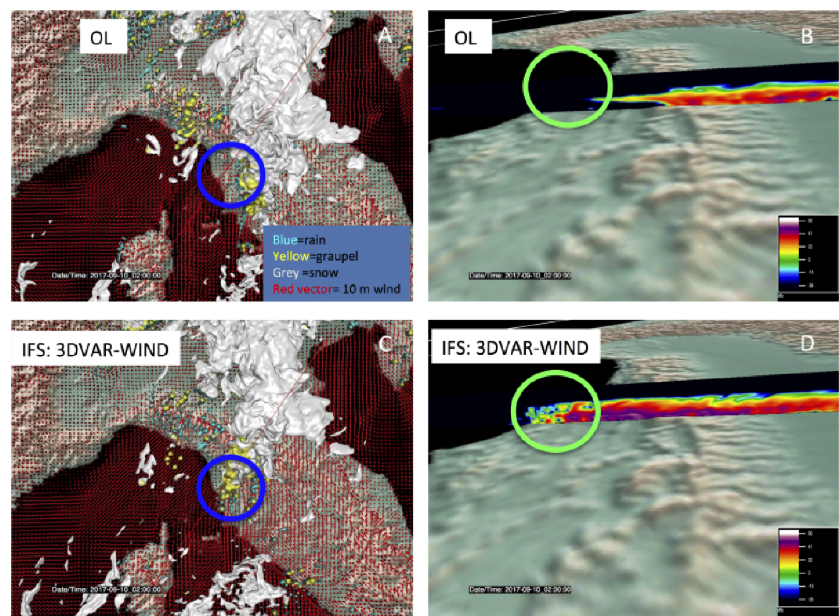
Figure 11. Comparison between the OL simulated structure with respect to the 3DVAR-WIND simulated structure at 02 UTC of 10 September 2017. Panels ( a , c ) report the 3D simulated structure composed by rainwater (cyano) graupel (yellow) and snow (grey) microphysical species respectively for OL ( a ) and 3DVAR-WIND ( c ) simulations with the horizontal 10m wind intensity represented by red vectors. The red line in Panels ( a , c ) indicates the location of the vertical section of the reflectivity values in the middle of the convective structure shown in panels ( b ) for OL and ( d ) for 3DVAR-WIND.